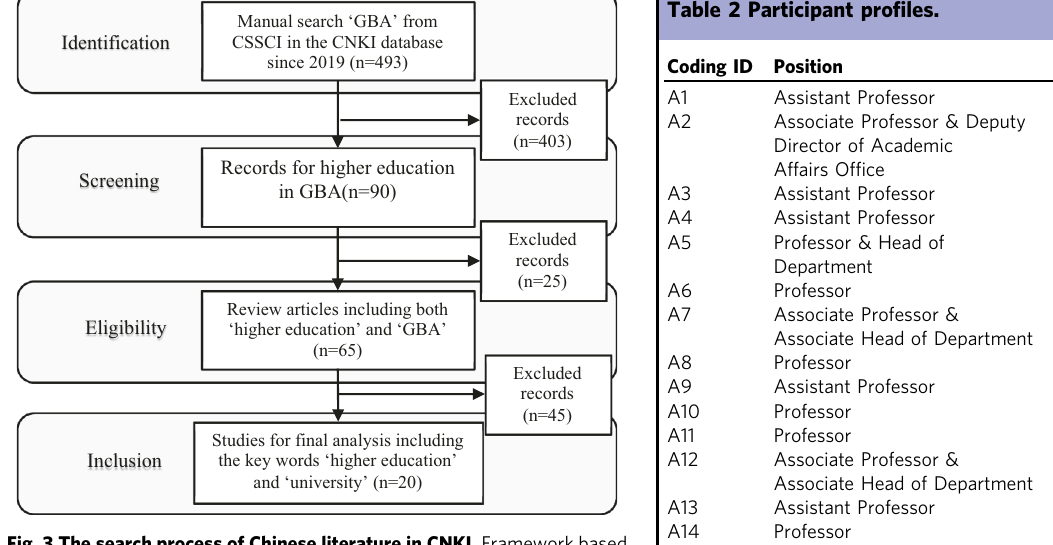
Fig. 3 The search process of Chinese literature in CNKI. Framework based on De los Reyes et al.